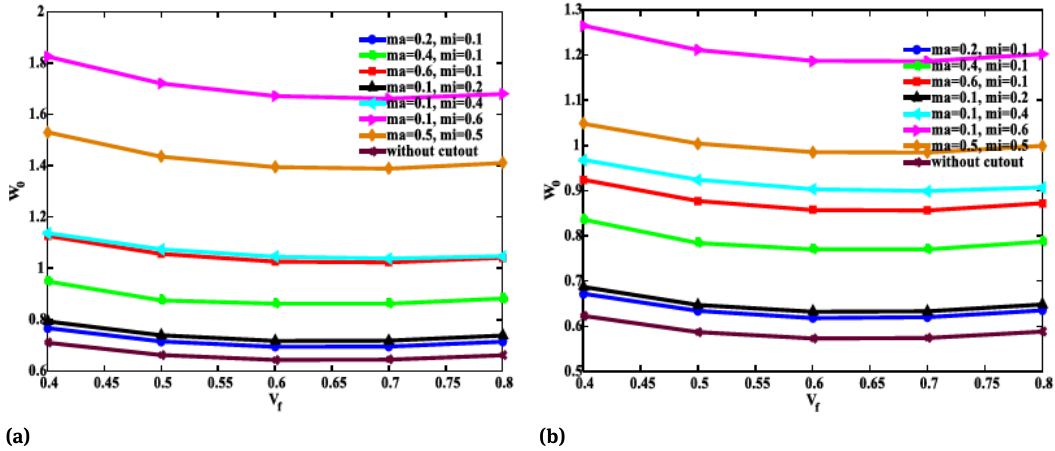
Figure 7: (a) Linear and (b) nonlinear, variation of NTMD with fiber volume fraction